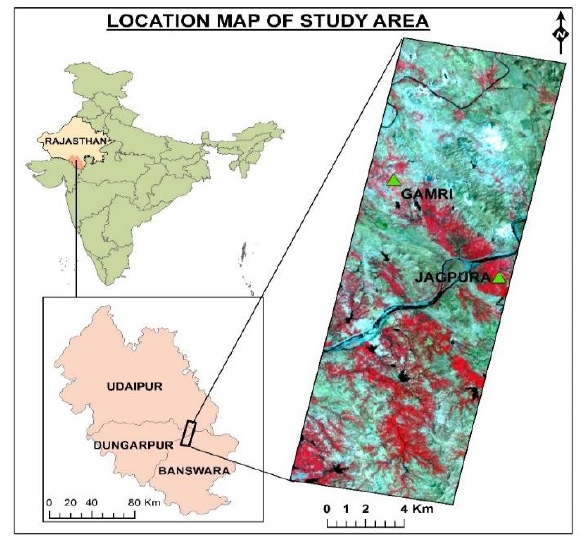
Figure 1. Location of study area displaying the Hyperion image taken for this study Longitudes 73 0 18’ 03.71”: 74 0 19’ 31.38” and Latitude 23 0 45’ 01.17”: 24 0 00’02.62” restrict the area of study, which falls in